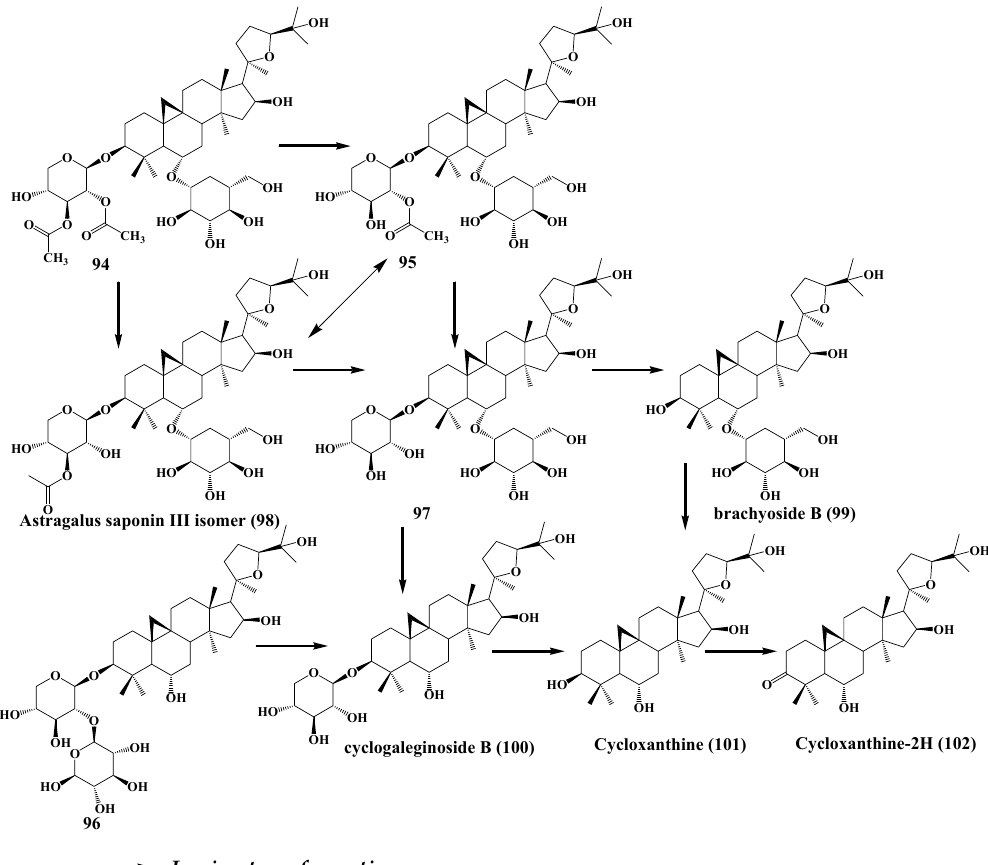
Figure17. Astragaloside through human intestinal flora transformation pathway. Figure 17. Astragaloside through human intestinal flora transformation